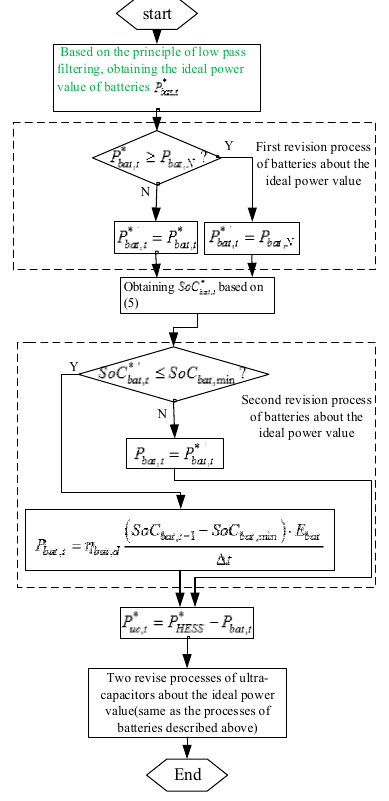
Figure 2. Power revision processes for batteries and ultracapacitors.